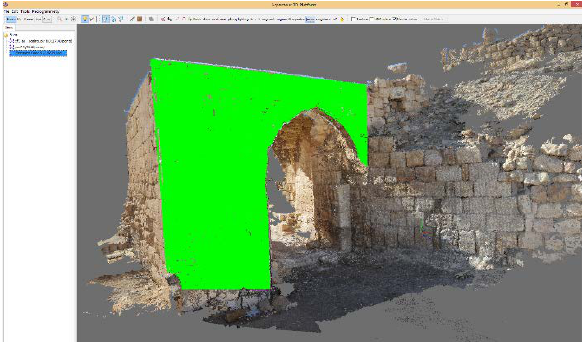
Figure 3 points that lie on the selected plane (green), Castle of Shawbak,